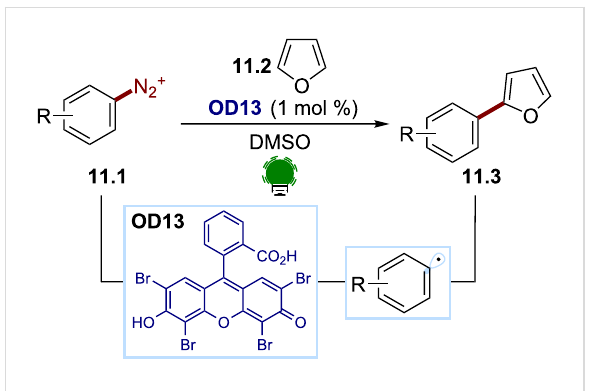
Scheme 11: Illustrative example for the photocatalytic reductive gener- ation of aryl radicals from aryl diazonium salts: the photocatalytic Meerwein arylation reported by König and co-workers